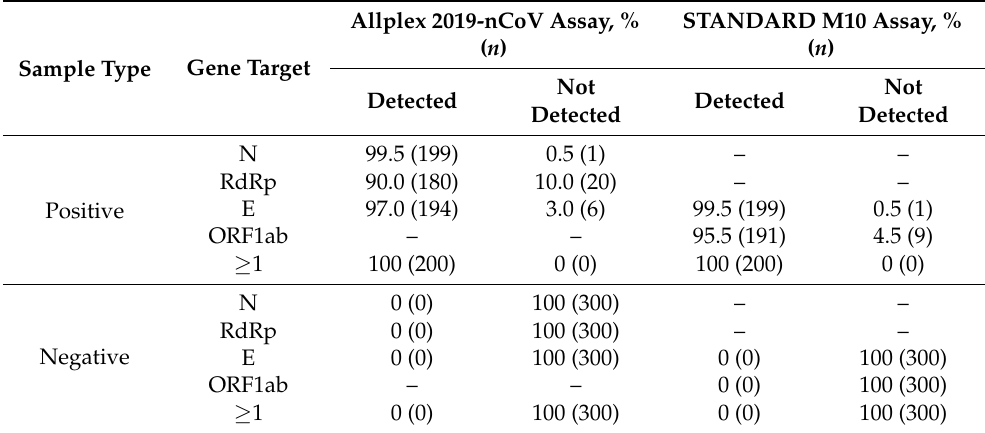
Table 1. Raw data on target detections by gene target and assay ( n = 500).